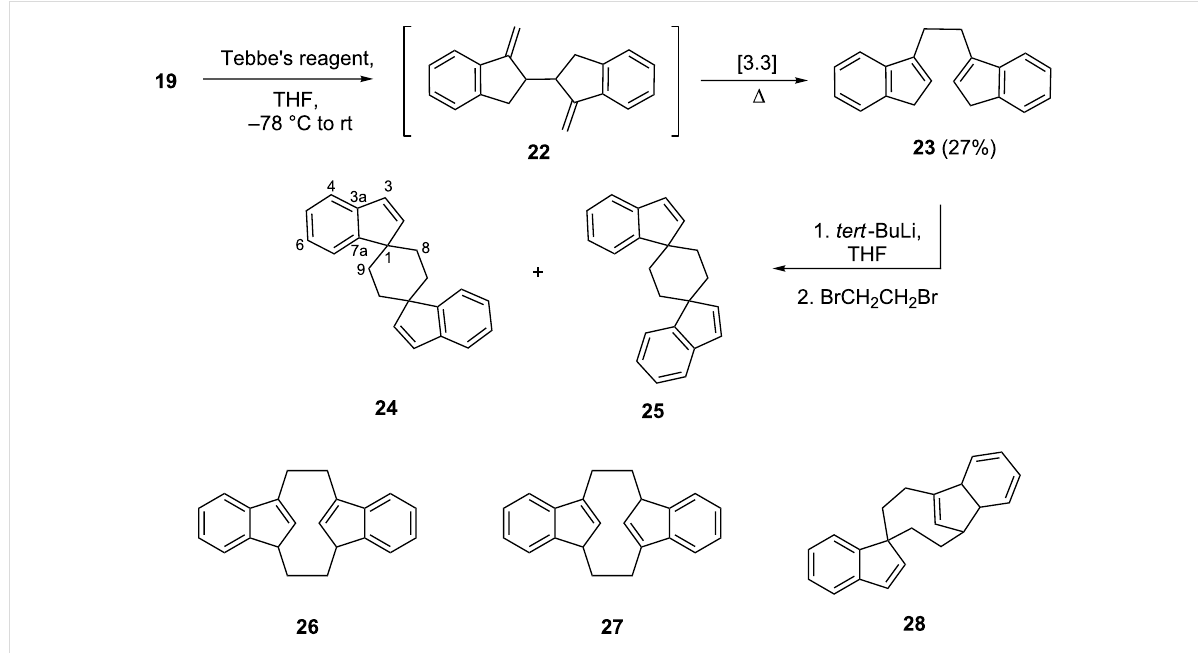
Scheme 5: Methylenation of 19 and bisalkylation of the product 23 with 1,2-dibromoethane.